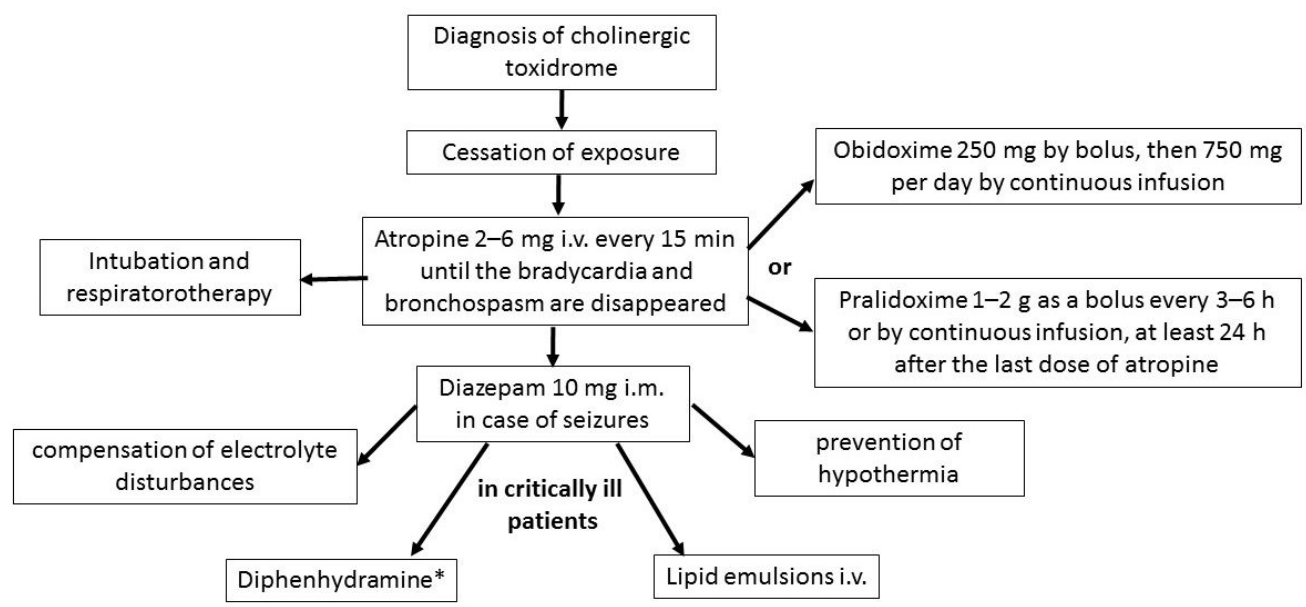
Figure 7. Procedure in the case of suspected Novichok poisoning (*—so far this therapy has been tested only on animals)